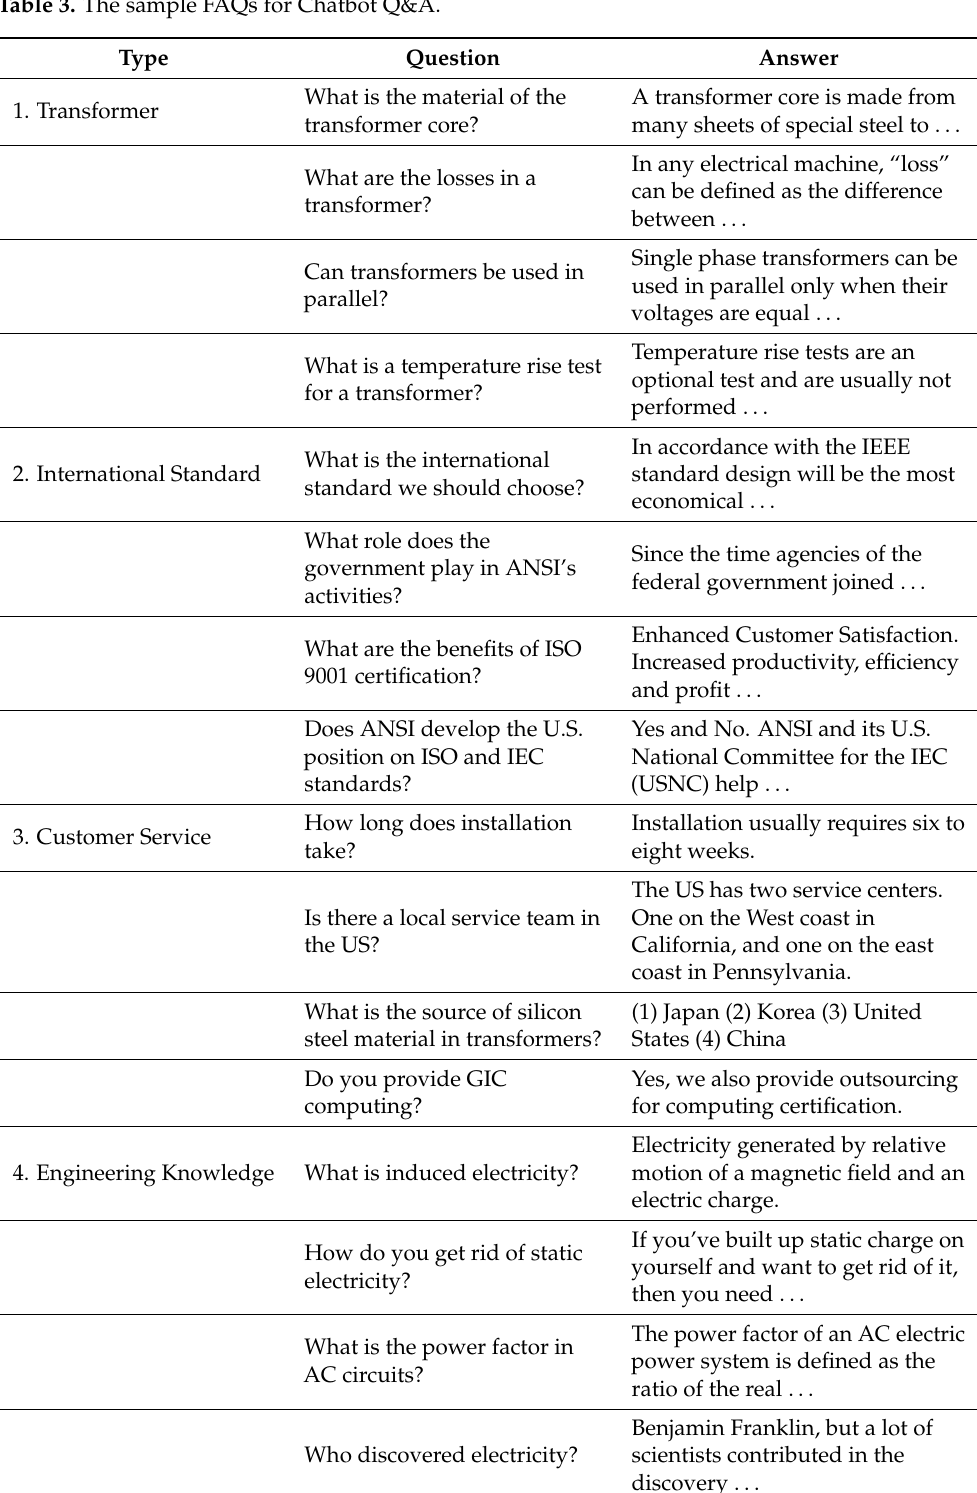
Table 3. The sample FAQs for Chatbot